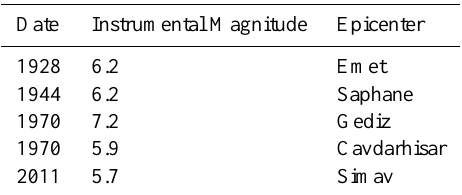
Table 1. Recent destructive earthquakes in the Aegean region of